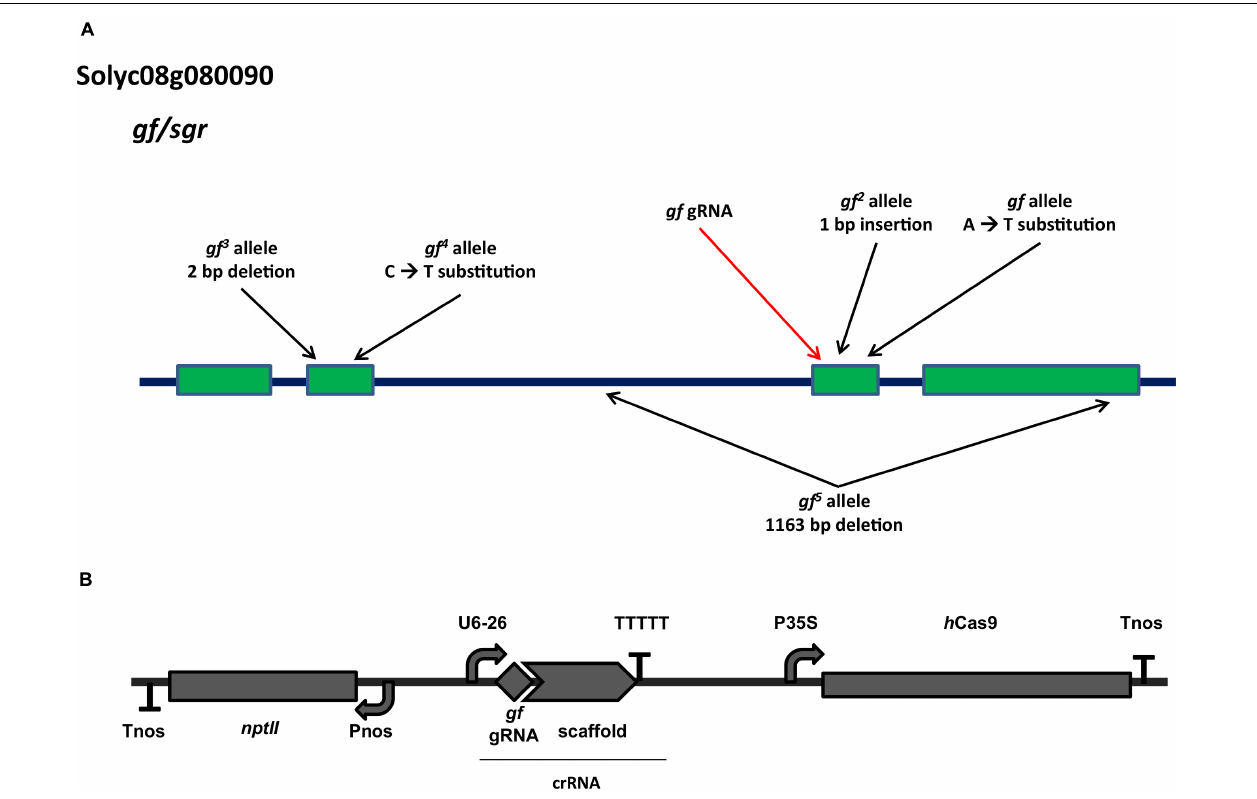
FIGURE 1 | Characteristics of the GF locus and of the gene editing construct. (A) Architecture of the Solyc08g080090 ( greenflesh ) locus and known natural mutations. The position of known mutations present in heirloom tomato varieties is indicated by black arrows. The red arrow indicates the position targeted by the gf gRNA used in this study. Adapted from Barry and Pandey (2009). (B) Architecture of the T-DNA used to generate tomato edited gf mutants. Expression of the Cas9 endonuclease is controlled by the CaMV 35S promoter and the nopaline synthase (nos) terminator; gRNA expression is driven by the Arabidopsis PolIII U6-26 promoter; the nptII selection marker for kanamycin resistance is expressed under the control of the nos